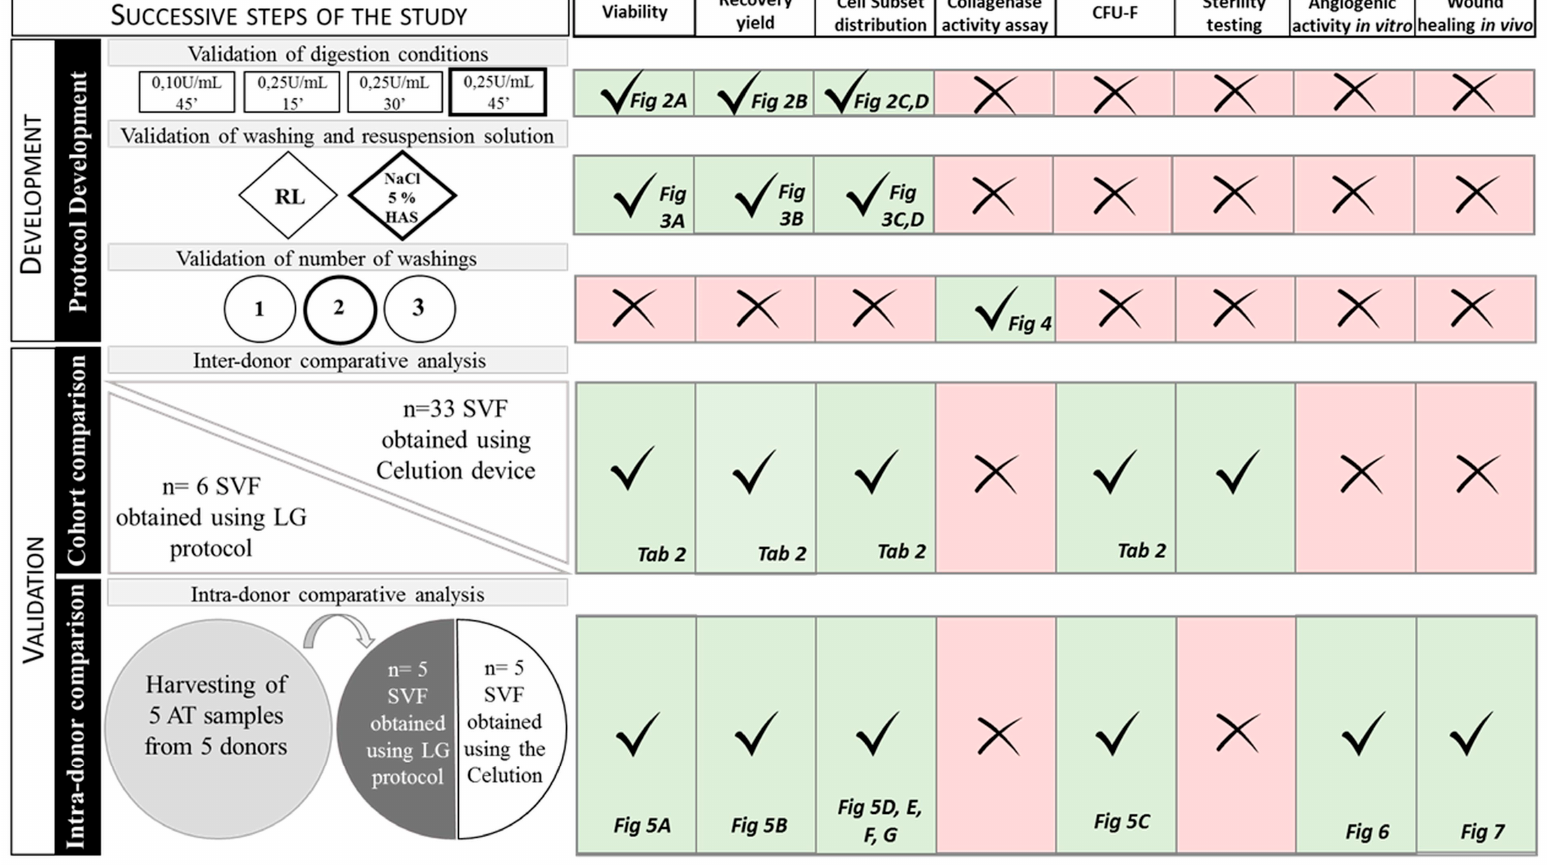
Figure 1. Development steps of the study . The different steps are presented from the top down according to the development chronology. Parameters evaluated at each step are listed, and the resulting figures are indicated. RL: Ringer’s solution. HAS: human serum albumin. SVF: stromal vascular fraction. AT: adipose tissue. Fig: figure; Tab: table. Cross by kareemov1000 from the Noun Project. Check by kareemovic3000 from the Noun Project.2.7. Biological Characterization of SVF.